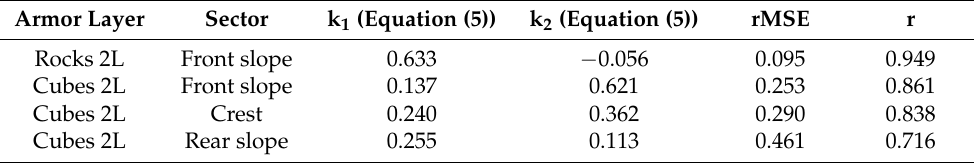
Table 3. Calibrated values of k 1 and k 2 for Equation (5) and rMSE and r values.